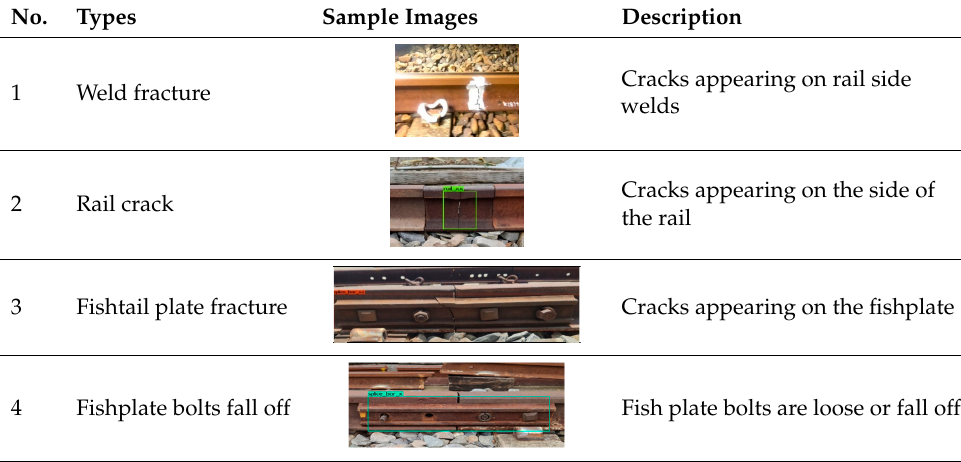
Table 4. Types of defective track components from the side view.